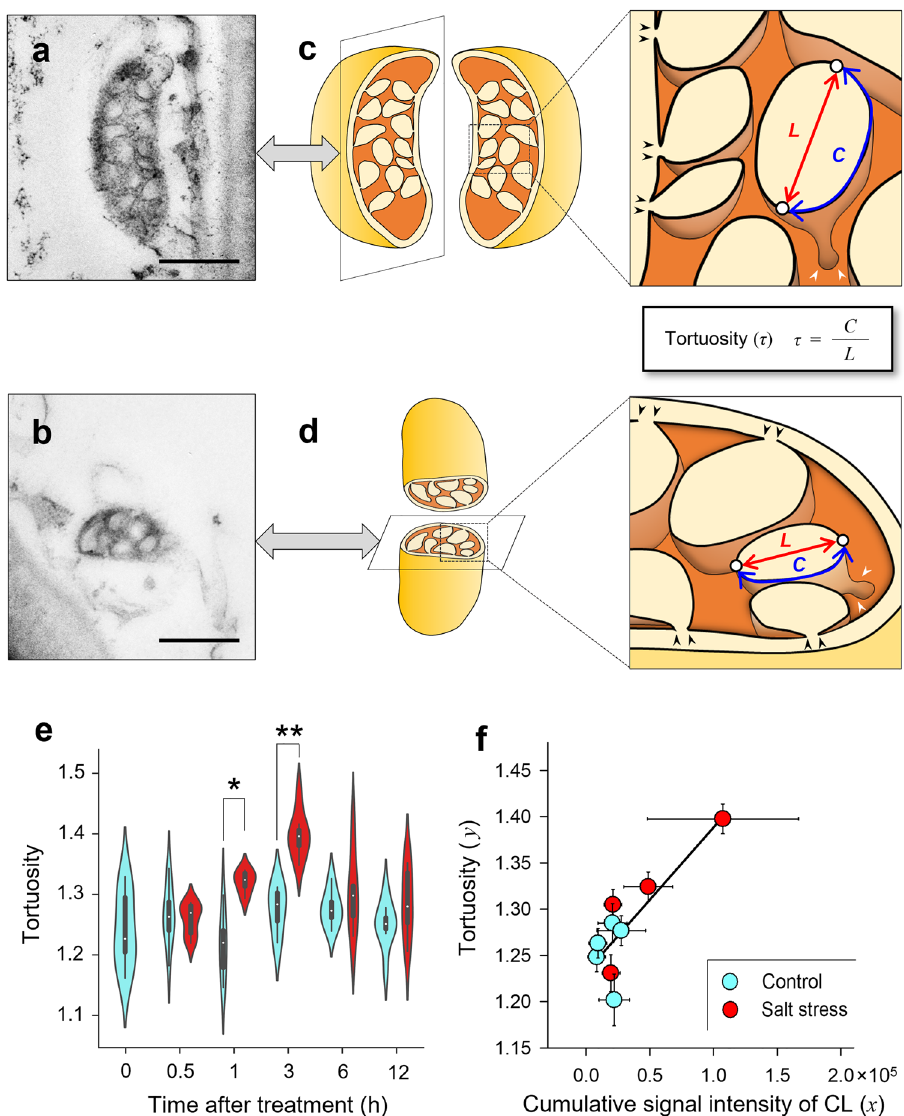
Figure 3. Morphological changes in the mitochondrial internal structures of tomato trichome stalk cells (see Methods) under salt stress conditions. Longitudinal ( a ) and transverse ( b ) sections of TEM images and their diagrams of mitochondrial internal structures with cristae junction model in the cells ( c and d ). In c and d , each expanded image shows the putative structure of tubulo-vesicular cristae at each section. Time-course of changes in tortuosity ( τ ) of the cristae determined by using an image analysis throughout the treatment ( e ), and τ plotted against the cumulative CL signal intensity from Fig. 2 f . Bars = 500 nm ( a and b ). In e and f , cyan and red plots indicate control and salt stress treatment, respectively. Data were obtained from 94 to 315 cristae in 16–44 mitochondria in 3–6 plants in each treatment. Significant difference at the 0.01 and 0.001 probability levels by t -test is indicated with * and **, respectively. Regression of τ and cumulative signal intensity of cardiolipin (CL) ( f ). Data are means ± SEs for 8–32 stalk cells from 3 to 6 plants. The regression line between the cumulative signal intensity of CL ( x ) and τ ( y ) in CL is y = − 0.16 × 10 −5 x + 1.23, with R 2 = 0.70 ( p < 0.005). A violin plot was created with Python 3.9.1. Creating a scatter plot and the linear regression were performed in SigmaPlot